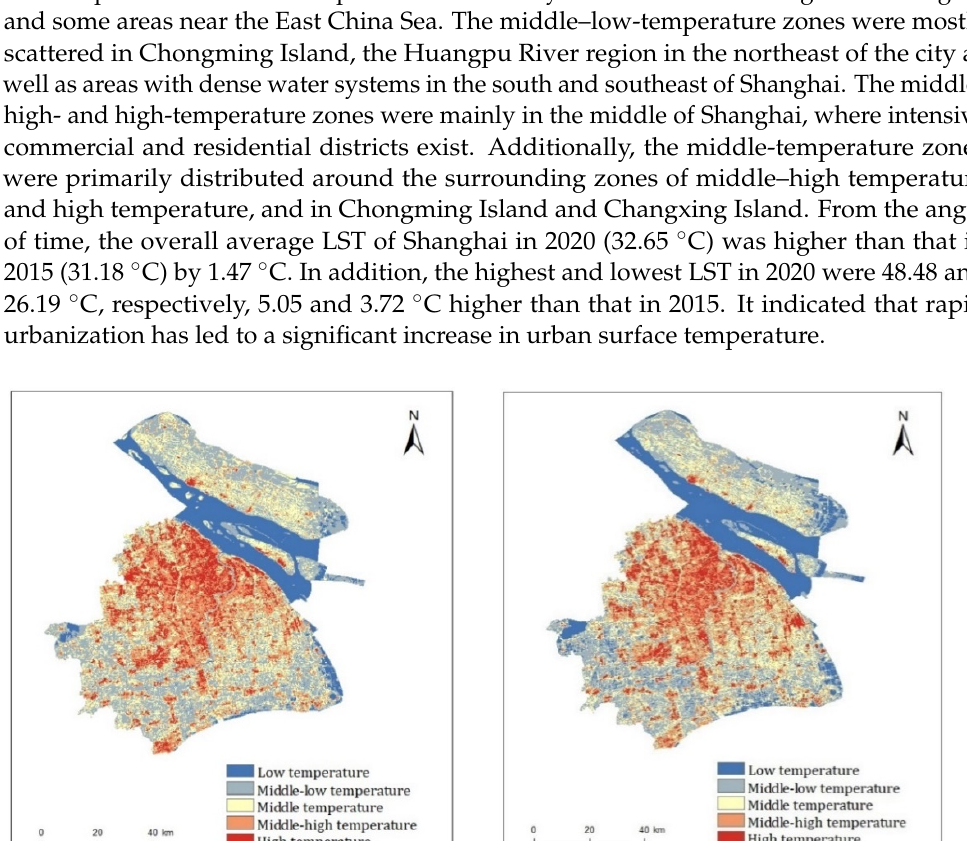
Table 3. Classification of Land Surface Temperature in Shanghai.